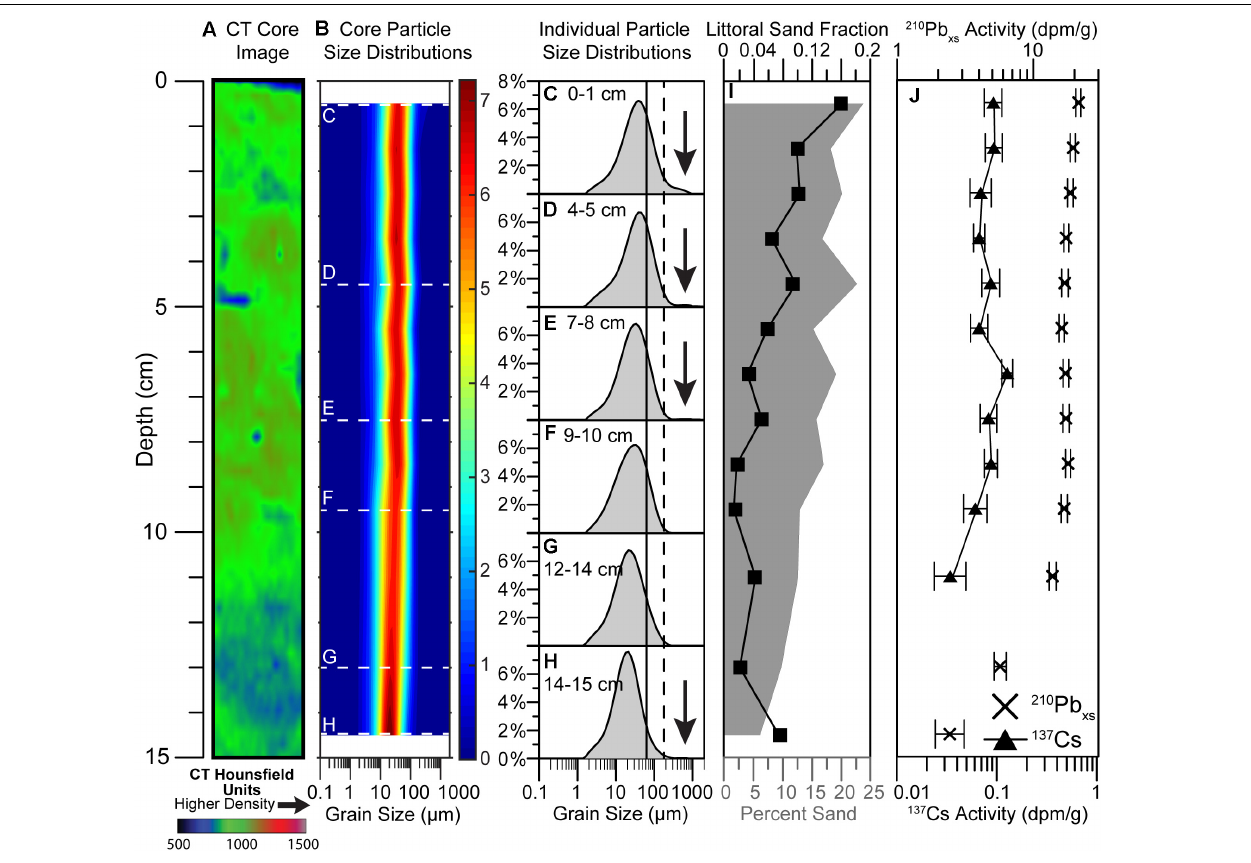
FIGURE 6 | Results from SR1707-02MC (see Figure 1 for location). (A) CT image of the core where cooler colors (blues and greens) are relatively lower density deposits, and warmer colors (reds) are higher density. (B) Down core total grain size distribution for all samples. In this plot the y-axis is depth down the core, x-axis is particle size, and the colors represent the volume present of the sample that fall within those size classifications, where warmer colors are higher percentages and cooler colors are lower percentages. The warmest color region across any depth horizon represents the mode for the sample. Representative individual sample particle size distributions (PSD) are shown in (C–H) , where the depths of these PSD are highlighted in (B) as white dashed lines. The solid black vertical line in (C–H) notes the silt/sand boundary at 63 µ m and the dashed black vertical line notes the Monterey Bay littoral cutoff diameter at 180 µ m (see text for explanation). Black arrows in the plot point to samples with increases in material coarser than the littoral cutoff diameter. The raw measurement size bins for the instrument were used to create the distributions in (B–H) . (I) Down core results from the grain size analysis with total percent sand (gray area) and the littoral sand fraction (black squares – see text for explanation). (J) Down core results for the 210 Pb xs (black Xs) and 137 Cs (black triangles). No Surface Mixed Layer was observed within this core, and 210 Pb xs was detected at the